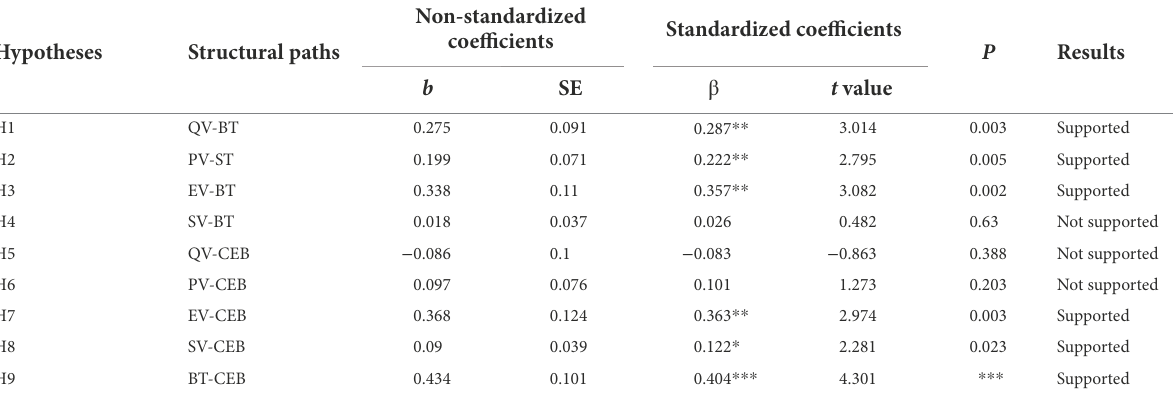
TABLE 3 Results of hypothesis